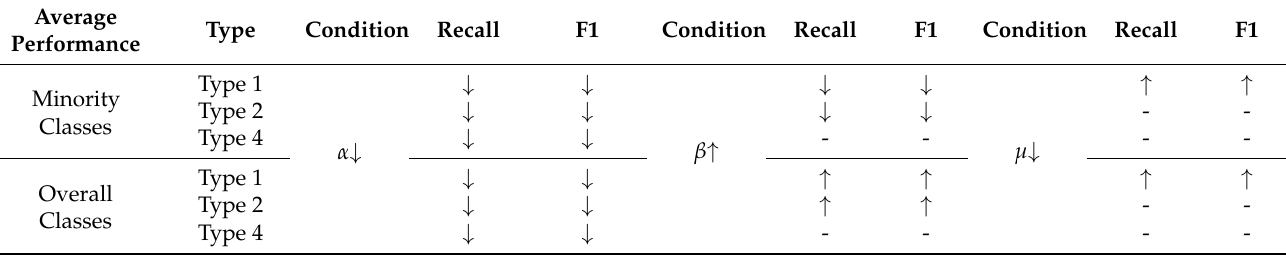
Figure 7. The effect of α on the classification performance of Type 4. ( a ) Moore Dataset; ( b ) CICIDS 2017 Dataset. Table 7. Parameters’ impact on classification performance of different dataset